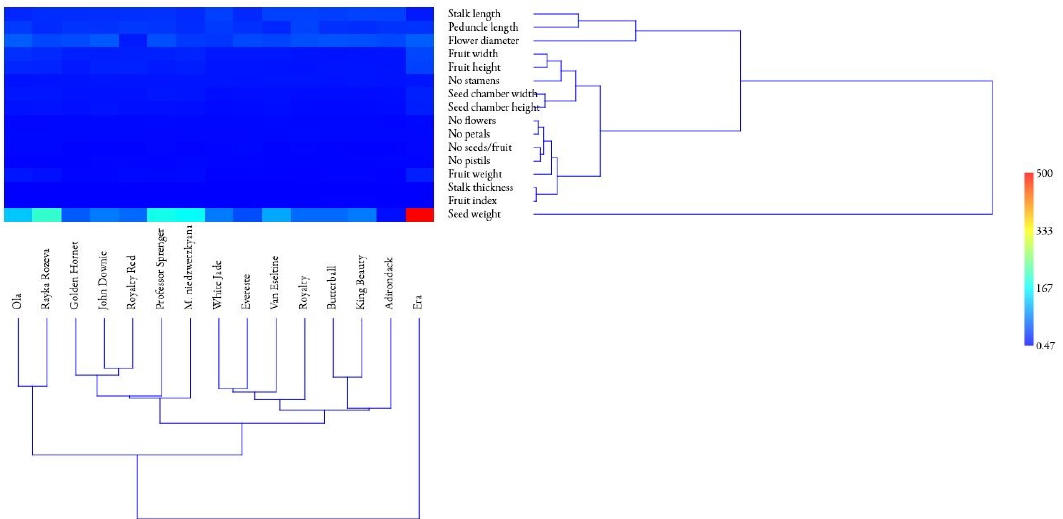
Figure 9. Clustering analyzes for 16 physico-morphological traits and 15 ornamental crab apple cultivars, performed by paired group algorithm – unweighted pair group method with arithmetic mean (UPGMA), Gover similarity